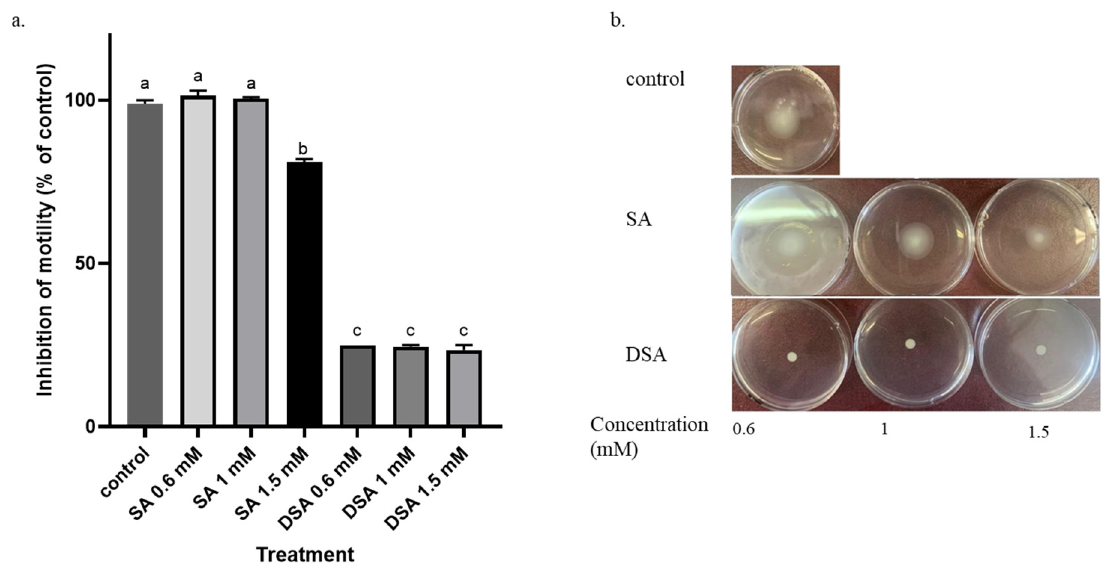
Figure 3. ( a ) Effects of nonlethal concentrations of DSA and SA on the swimming motility of Pectobacterium brasiliense Pb1692. Bars represent mean diameter of motility + SE for 4 independent experiments, each with 3 replicates. Bars that are not labelled with the same letter are significantly different from each other ( p < 0.05; bar = SE; n = 4). ( b ) Pb1692 was applied to the center of each plate containing soft agar following exposure to SA or DSA at the above concentrations or DDW (control). Bacteria were grown at 28 °C in 0.3% agar. The motility diameter was measured after 24 h. One-way ANOVA and post hoc Tukey-Kramer HSD tests were used to analyze differences. The analysis was performed using GraphPad Prism